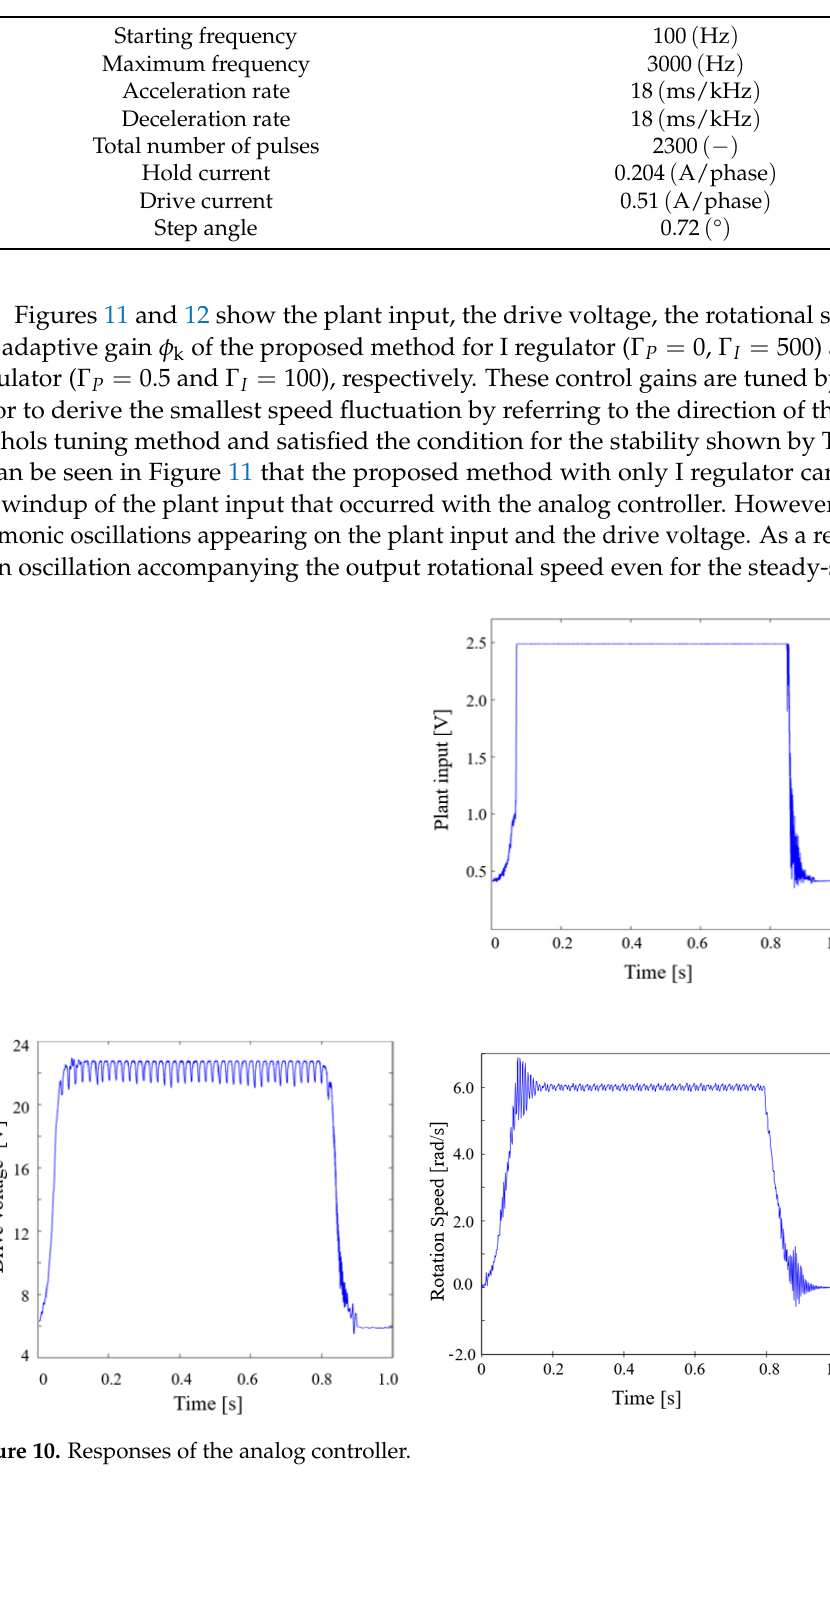
Table 1. The parameters for the trapezoidal drive.